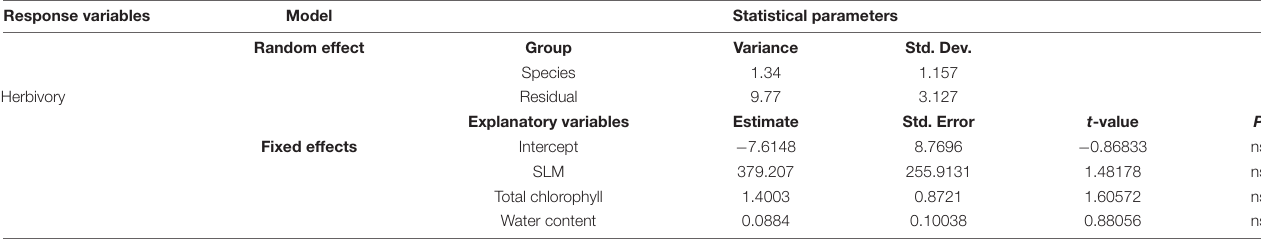
TABLE 3 | Results of the generalized mixed effect linear models (GLMMs) evaluating the effects of specific leaf mass (SLM), total chlorophyll and water content on herbivory (percentage of leaf area